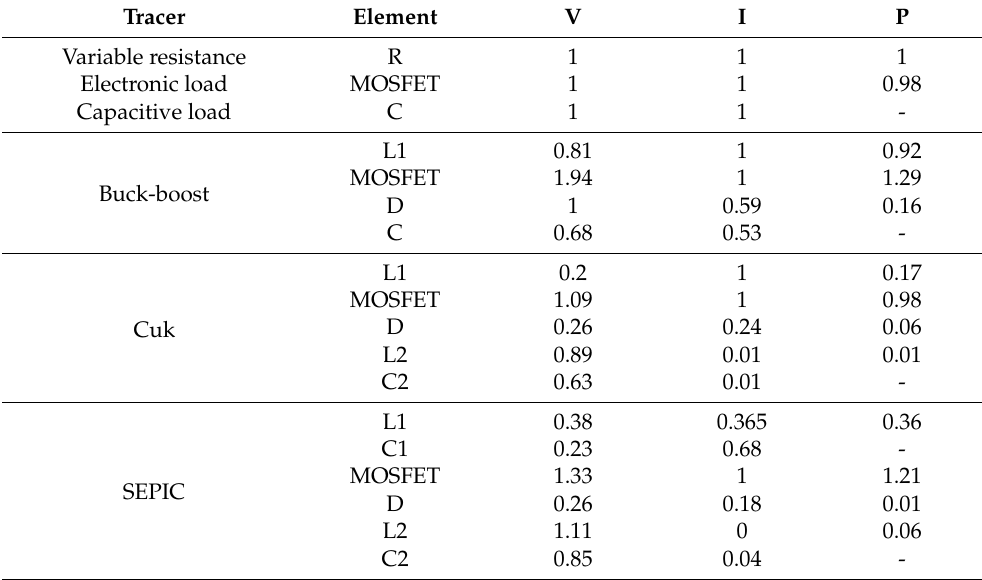
Table 3. Per unit electrical parameters of the elements in tracers. Tracer Element V I P Variable resistance